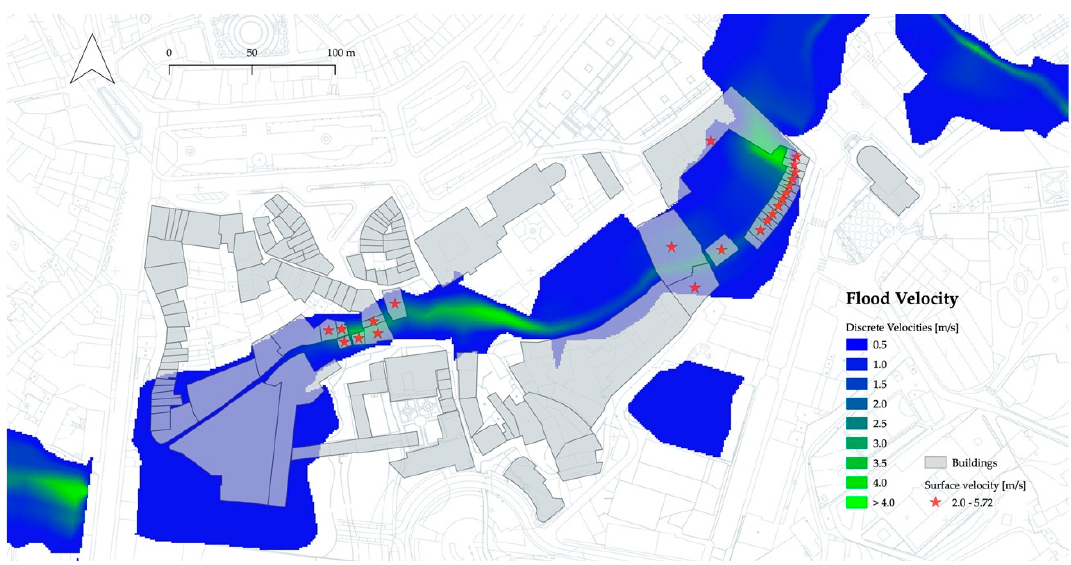
Figure 5. Flood velocities resulted from the adopted 100-year peak flow scenario.